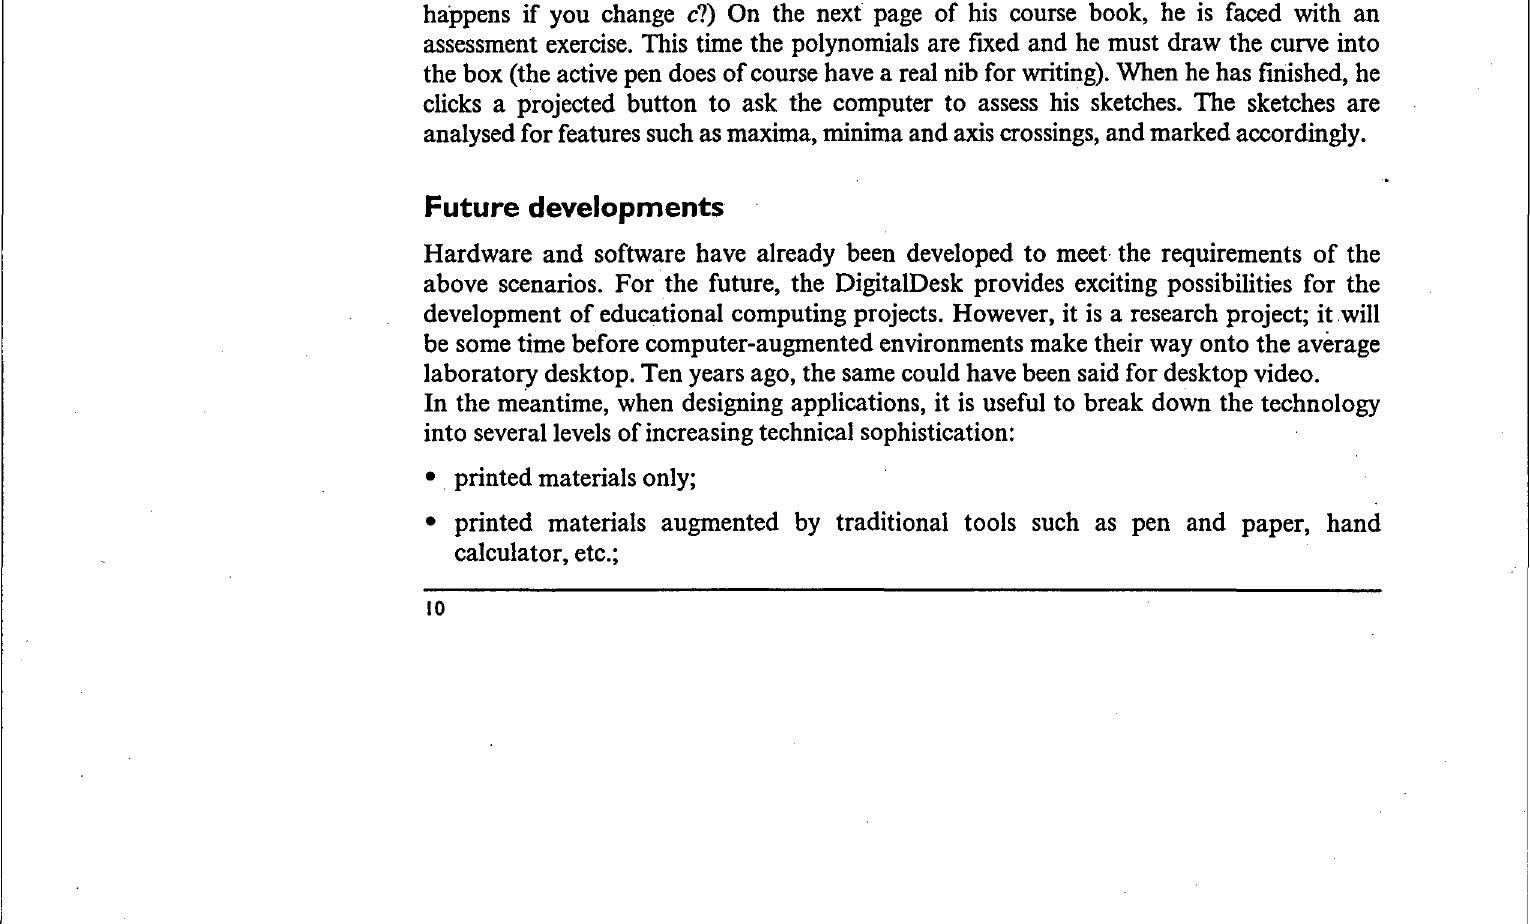
figure 3:7?ie D/g/to/Desk brings paper publications to life first placed on the desk. During a section on curve-sketching, he reads about polynomials. The generic equation of a quadratic polynomial is given with spaces for the values of the coefficients and an empty box underneath for plotting the graph. The software projects default values and draws the graph into the box. However, it also projects controls alongside the coefficients to allow him to change these values while observing the corresponding change in the graph (perhaps in response to a rhetorical question like: What happens if you change c?) On the next page of his course book, he is faced with an assessment exercise. This time the polynomials are fixed and he must draw the curve into the box (the active pen does of course have a real nib for writing). When he has finished, he clicks a projected button to ask the computer to assess his sketches. The sketches are analysed for features such as maxima, minima and axis crossings, and marked